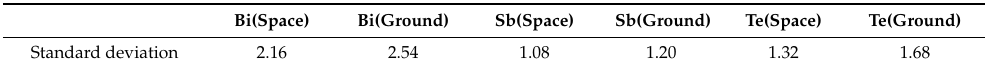
Figure 10. Atomic composition profile of crystals ( a ) along the growth direction, along the radial direction ( b ) at L = 5 mm, ( c ) at L = 15 mm, ( d ) at L = 24 mm. L represents the distance between the observation position and the starting position of zone melting. Table 2. Standard deviation of element distribution in bismuth telluride-based crystal materials prepared in space and on ground.